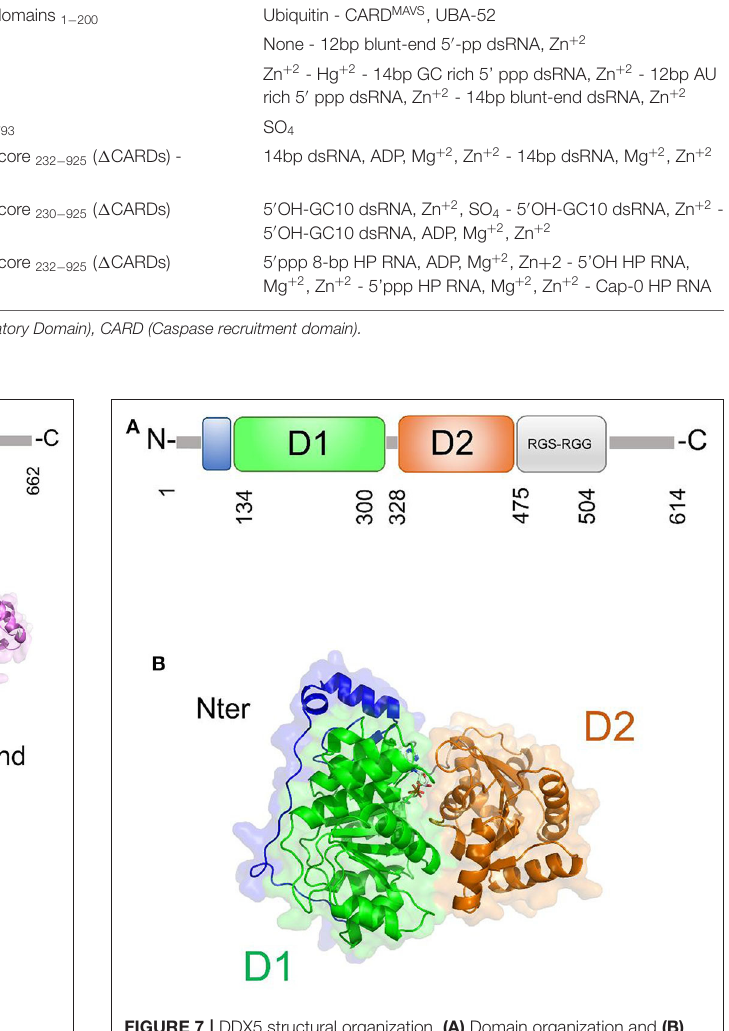
FIGURE 7 | DDX5 structural organization. (A) Domain organization and (B) cartoon representation of the homology model of DDX5, obtained using Modeler and the structure of DDX17 (pdb code 6uv1, covered region 35–476, seqid 83.7%) as a template. (Zhang et al., 2011). In this context, the DDX1-DDX21-DHX36 complex helps the innate immune system to detect viral infection by sensing viral nucleic acids cells (Zhang et al., 2011). Targeting of this complex by the N protein plays a role in immune evasion, possibly interfering with the formation of the sensor complex or by inhibiting the recognition of dsRNA by DDX1.